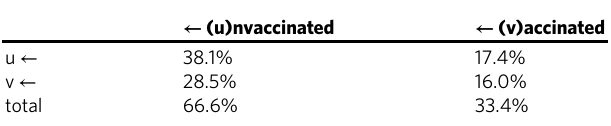
Table 3 Relative contributions to R from infections between vaccinated and unvaccinated groups for the “ medium ef fi cacy ” scenario.